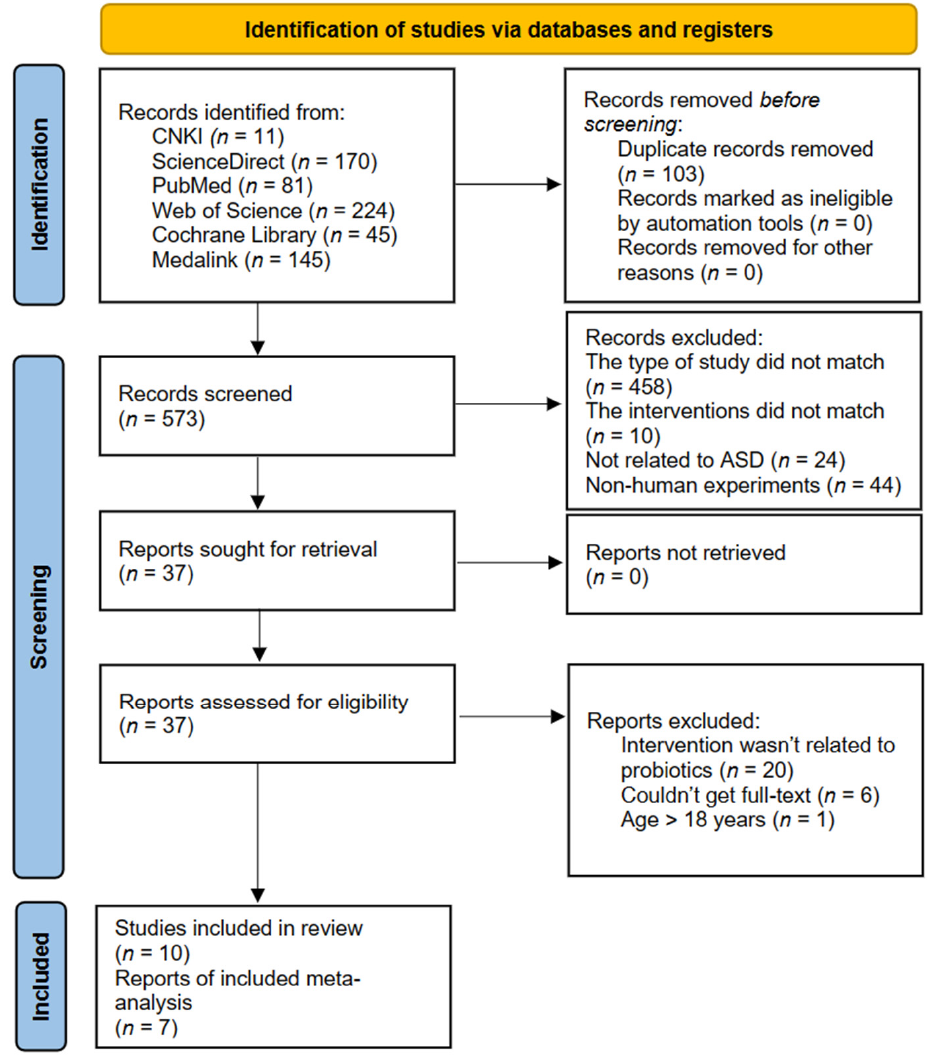
Figure 1. PRISMA flow diagram.